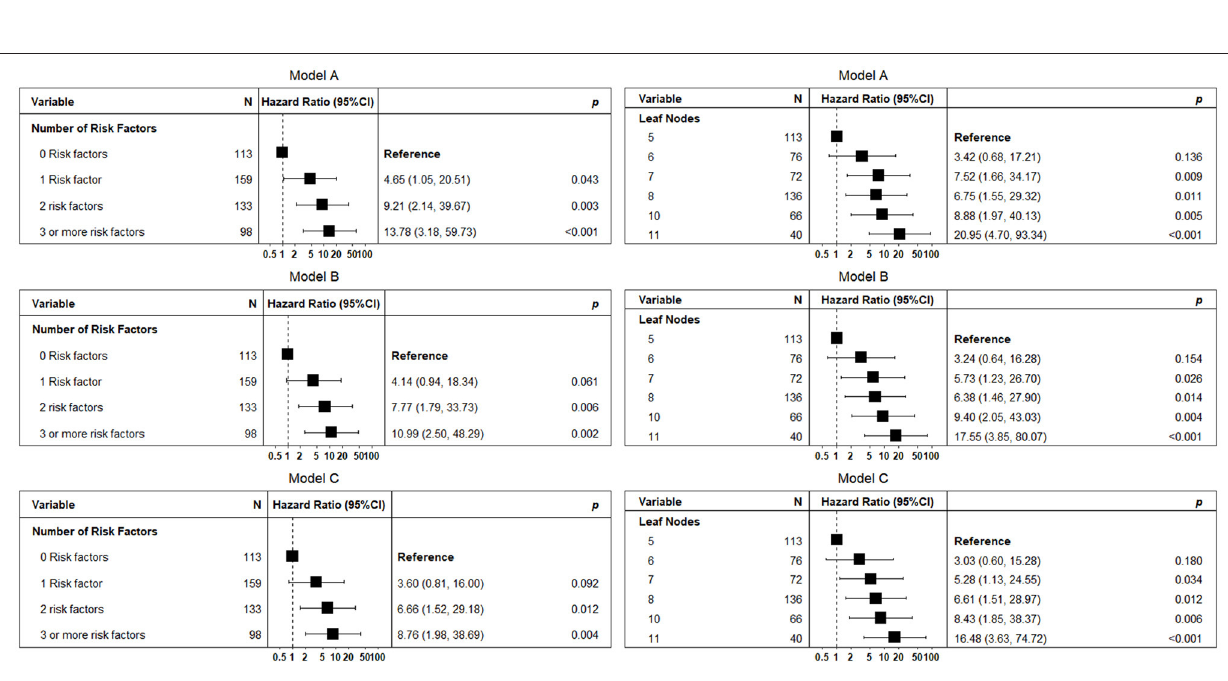
Frontiers in Medicine | www.frontiersin.org